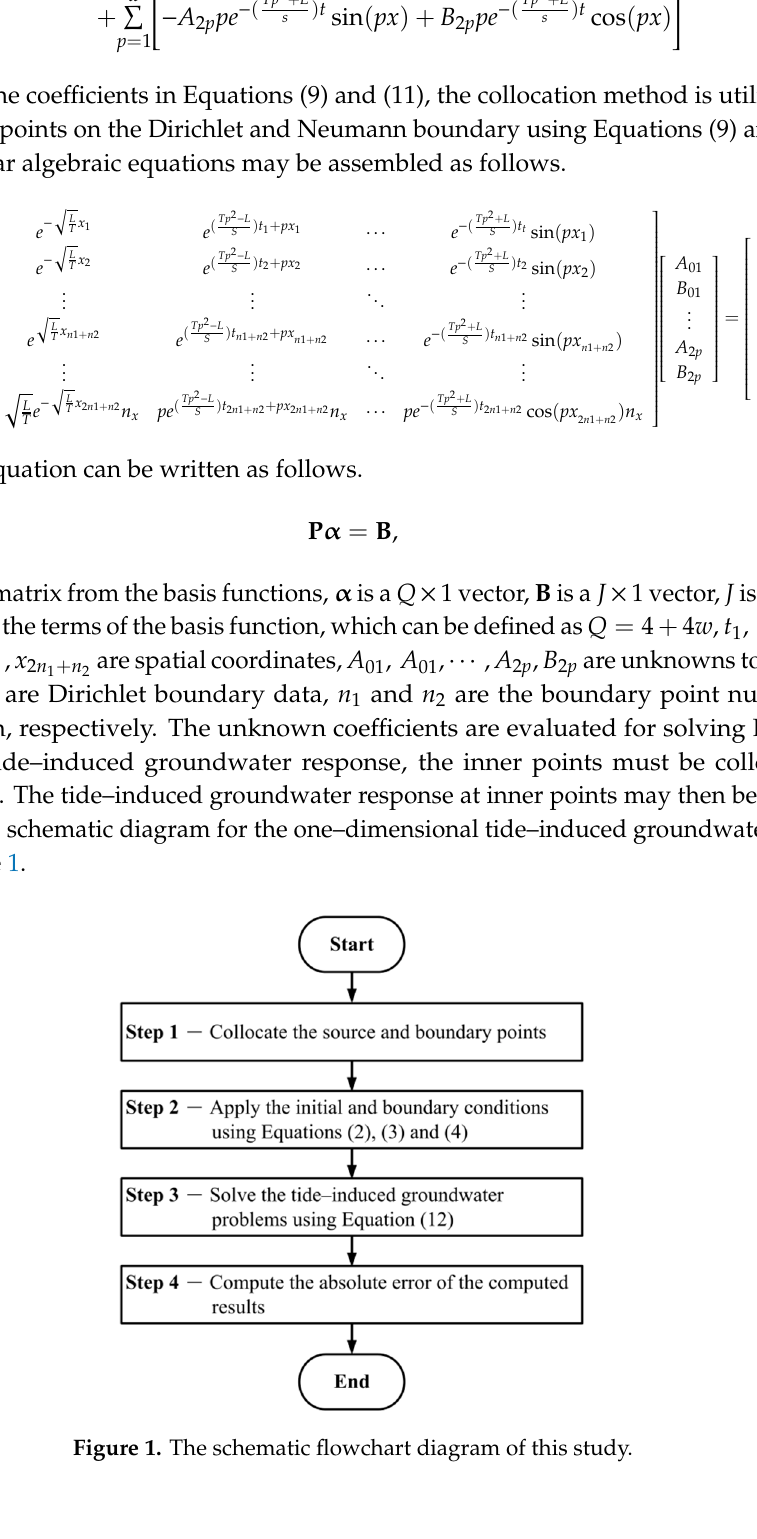
( b ) Figure 2. Conventional one-dimensional domain and the spacetime domain: ( a ) conventional one-dimensional transient problem; ( b ) boundary points of the problem in the spacetime domain. 4. Numerical Examples Five numerical implementations are conducted to investigate the accuracy of the proposed method. The objective of each numerical example is depicted in Table 1. In numerical examples 1 and 2, we conduct the sensitivity analysis and results comparison with the analytical solution. In the numerical example 3 and 4, we compare the accuracy of the proposed method with that of the time–marching finite difference method (FDM). Furthermore, we consider an application example in numerical example 5, where a time series of real tidal fluctuation data recorded at Xing–Da port by the Ministry of Economic Affairs Water Resources Department are used to study tide–induced groundwater flow problems.